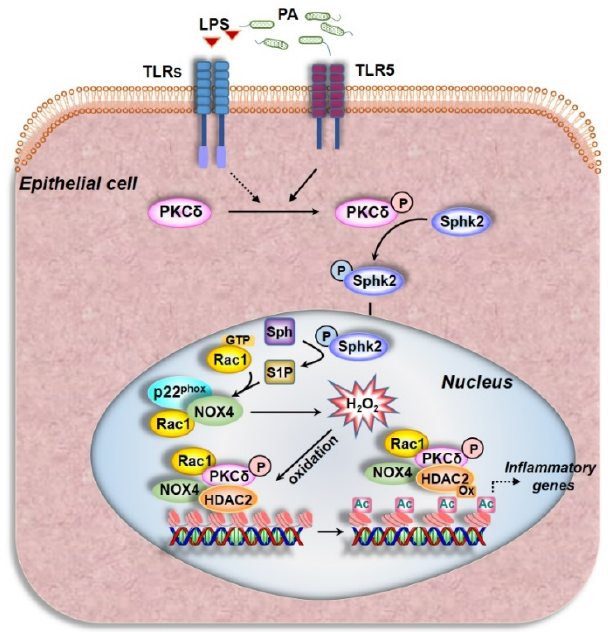
Figure 9. Schema depicting the role of PKC δ , RAC1, and SPHK2 signaling in nuclear NOX4- dependent ROS generation, HDAC2 oxidation, and H3/H4 histone acetylation mediated by P. aeruginosa in the lung epithelium. P. aeruginosa ( PA ) infection of lung epithelial cells in mouse lung or in culture phosphorylates and activates PKC δ , via Toll-like receptor (TLR) 5, which phosphorylates SPHK2 generating nuclear S1P. P. aeruginosa via lipopolysaccharide (LPS) and TLR2/4 might stimulate and phosphorylate PKC δ ; however, LPS does not increase nuclear ROS mediated by PA . The PKC δ /SPHK2 signaling increases nuclear ROS (hydrogen peroxide) via nuclear NOX4 as downregulation or inhibition of NOX4 reduces nuclear ROS. PA also activates nuclear RAC1 that is PKC δ -dependent. Inhibition of RAC1 with an inhibitor, NSC23766, reduces PA -induced nuclear ROS in lung epithelial cells. Generation of NOX4-dependent nuclear ROS modulates HDAC1/2 activity by oxidation of HDAC1/2. Further, in the nucleus, PA enhances the association between HDAC1/2 and NOX4, PKC δ , and RAC1. Thus, nuclear NOX4 modulation of HDAC1/2 activity via its oxidation leads to chromatin remodeling, which can potentially regulate inflammation. The dotted lines in the schema indicate pathways yet to be demonstrated, in vitro, in lung epithelial cells. PA , Pseudomonas aeruginosa ; PKC, protein kinase C; SPHK2, sphingosine kinase 2; S1P, sphingosine-1-phosphate; Sph, sphingosine; NOX4, NADPH Oxidase 4; Ox HDAC, oxidized histone deacetylase; LPS, lipopolysaccharide; Rac1, Ras-related C3 botulinum toxin substrate 1; TLR, toll-like receptor; Ac, acetyl.